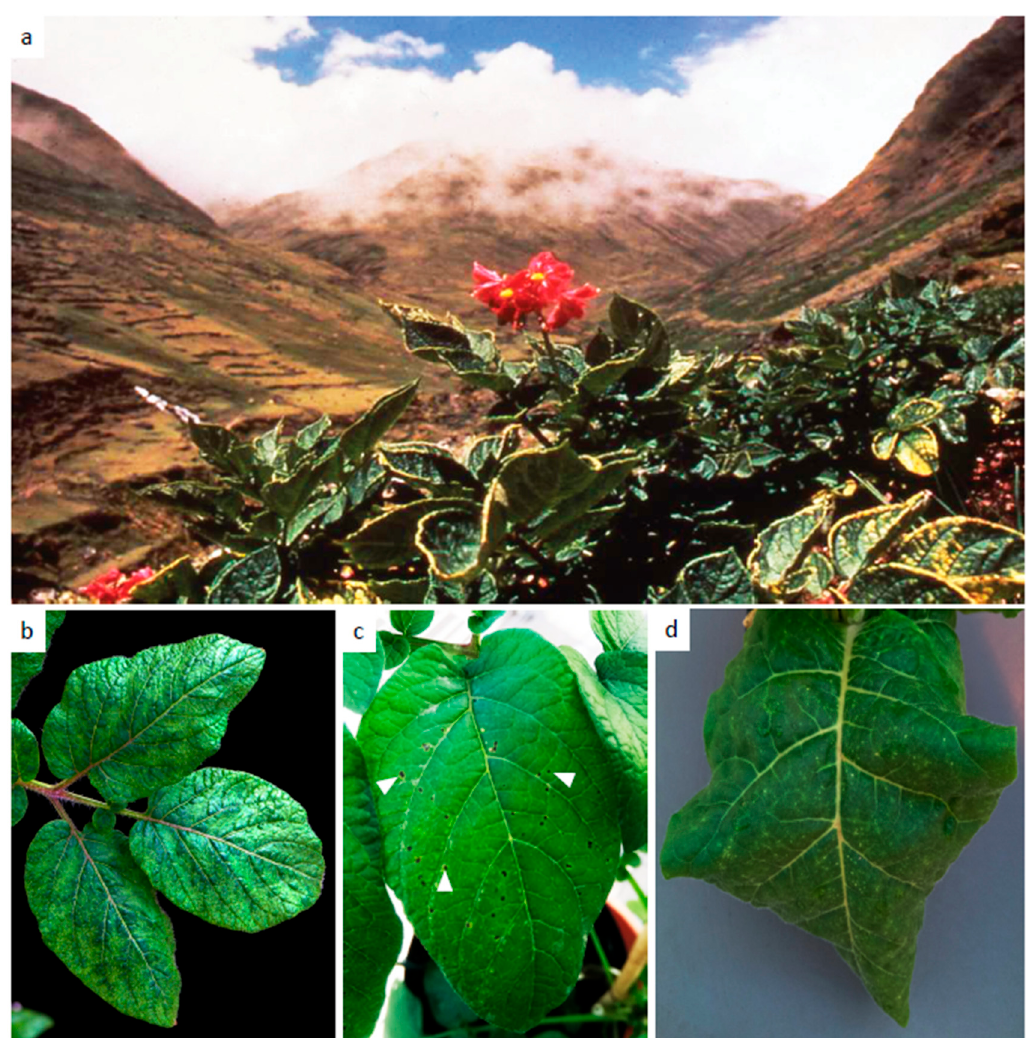
Figure 1. ( a ) Potato cultivation in the high Andes of Bolivia; ( b ) symptoms of O (ordinary) strain Potato virus Y (PVY O ) on leaves of Solanum tuberosum Group Phureja ( c ) necrotic local lesions (indicated by white arrow heads) elicited by PVY O in the inoculated leaves of potato cv Atlantic; ( d ) necrotic symptoms induced by N (necrotic) strain Potato virus Y (PVY N ) in tobacco leaves.